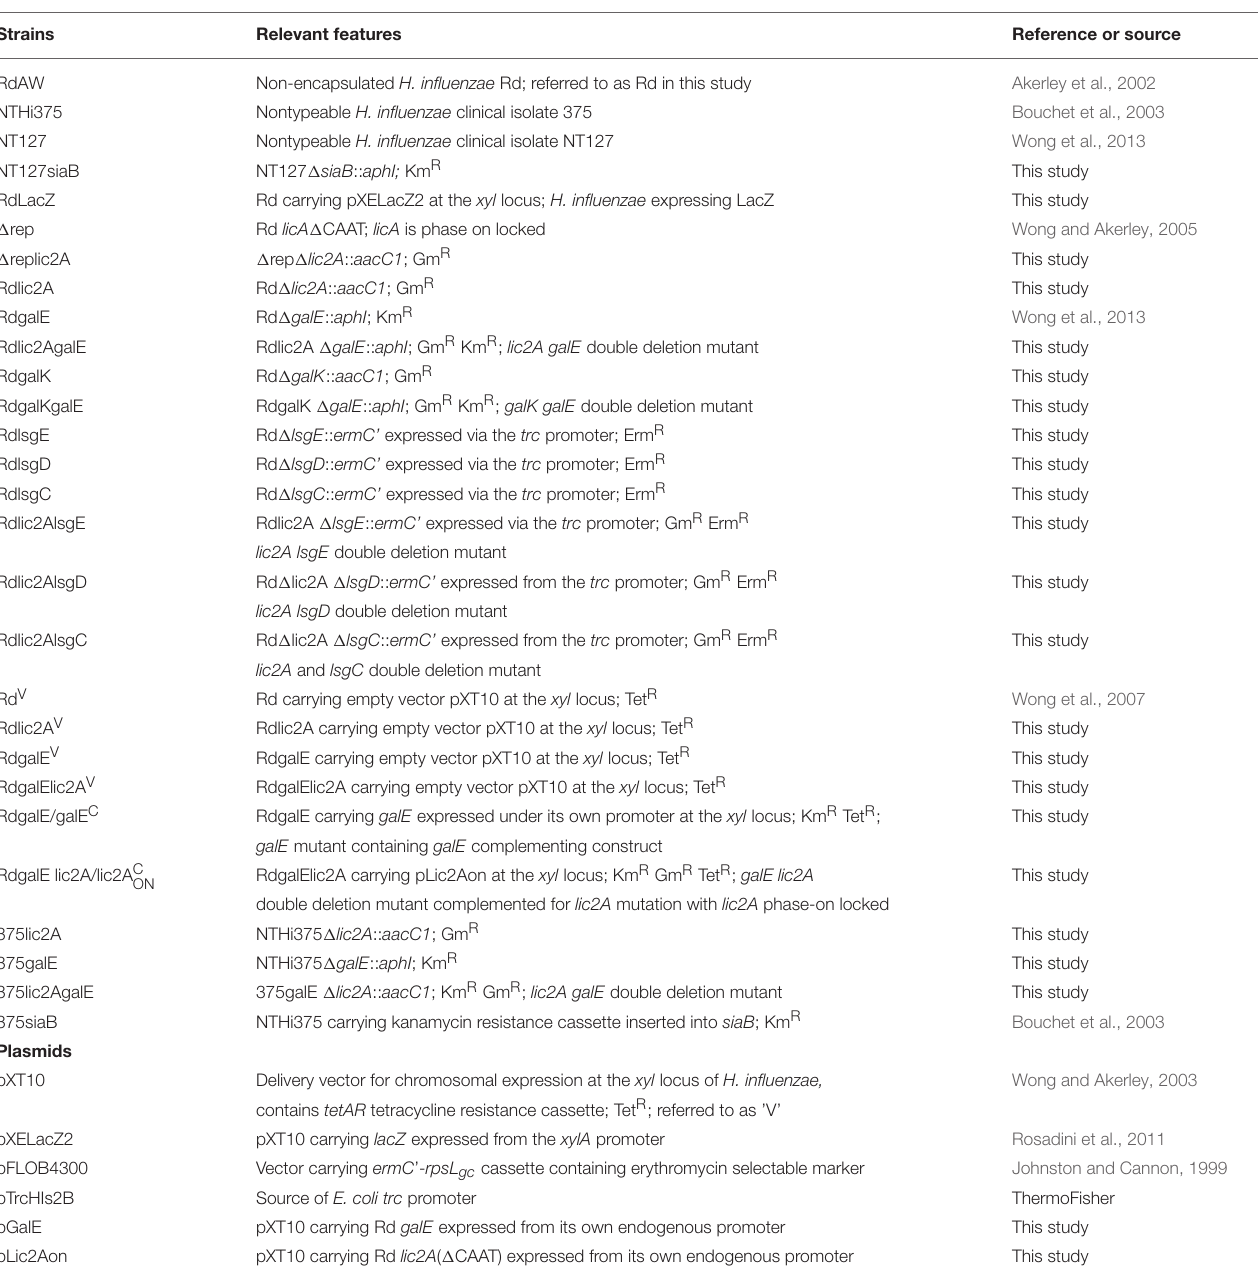
TABLE 1 | H. influenzae strains and plasmids used in this study.